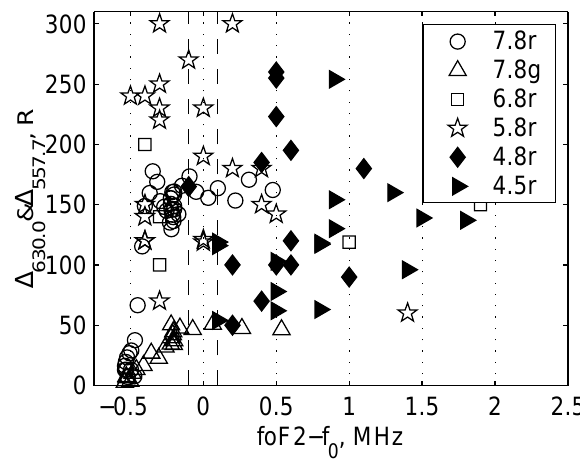
Fig. 6. Summary plot of the variation of the HF-induced airglow at MZ with f o F2 − f 0 . Here 7 . 8 ,... 4 . 5 stand for f 0 = 7 . 8 ,... 4 . 5MHz; r and g indicate red- and green-line emissions; vertical dashed lines show ± 0 . 1MHz